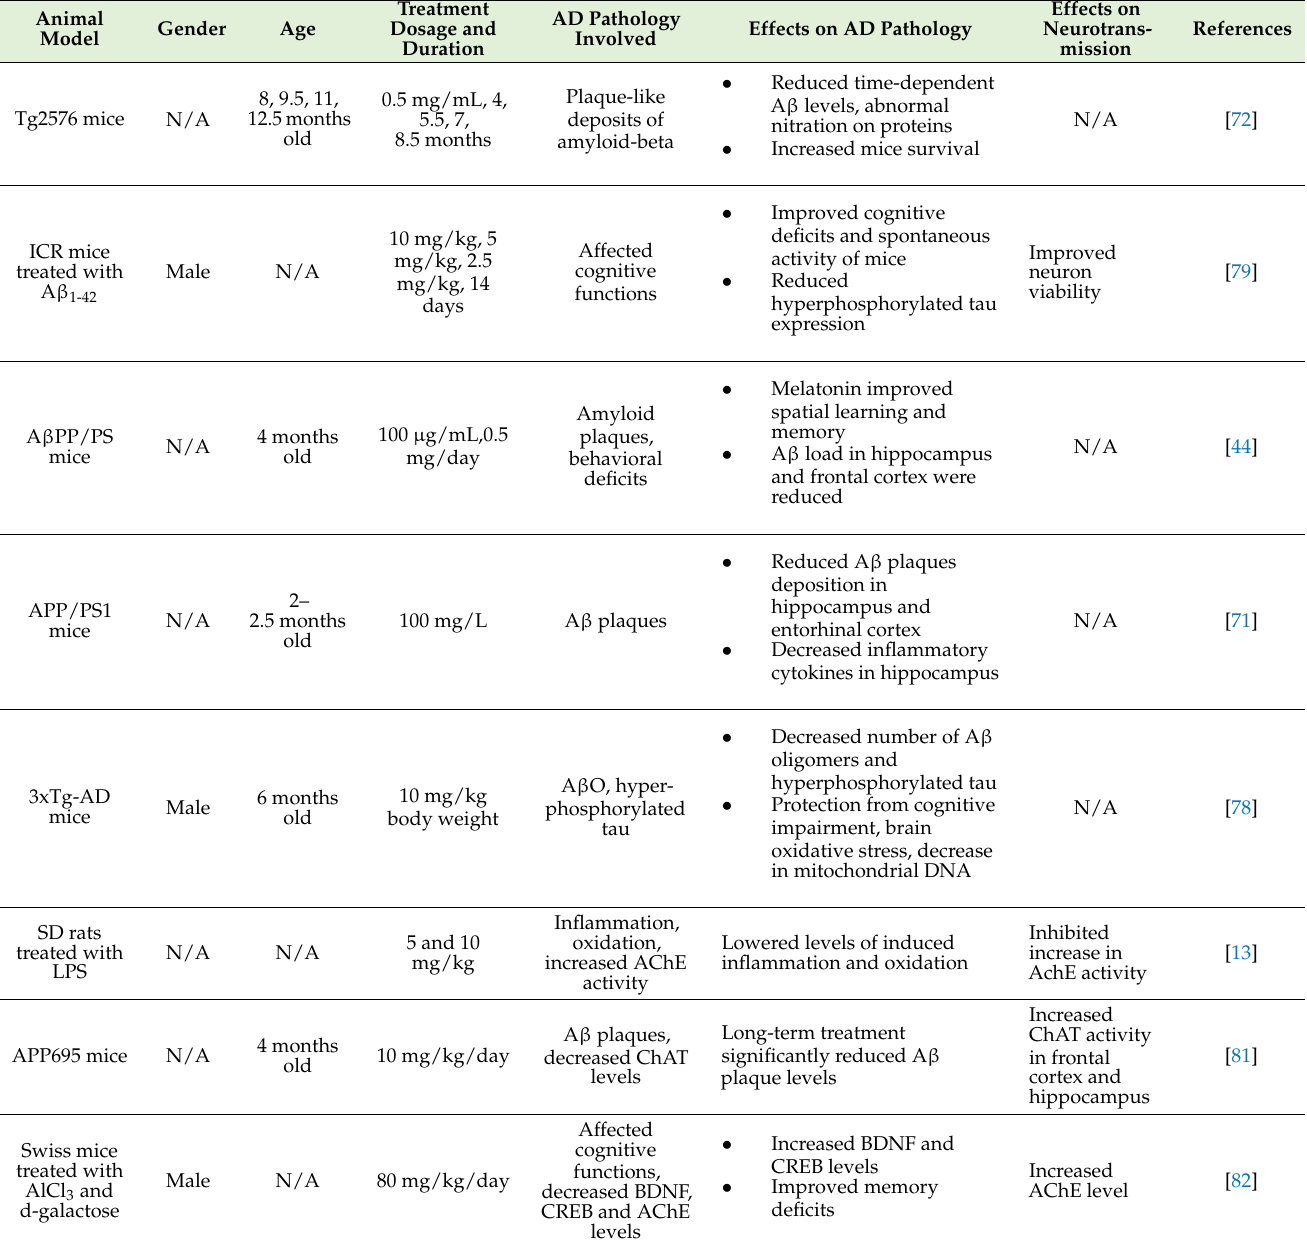
Table 3. In vivo studies related to the neuroprotective effects of melatonin in AD. Abbreviations: AChE, Acetylcholinesterase; APP, Amyloid-beta precursor protein; A β , Amyloid-beta, A β O, Amyloid-beta oligomers; BDNF, Brain-derived neurotrophic factor; ChAT, Choline acetyltransferase; CREB, cAMP Response Element-Binding Protein; LPS, Lipopolysaccharides; SD, Sprague